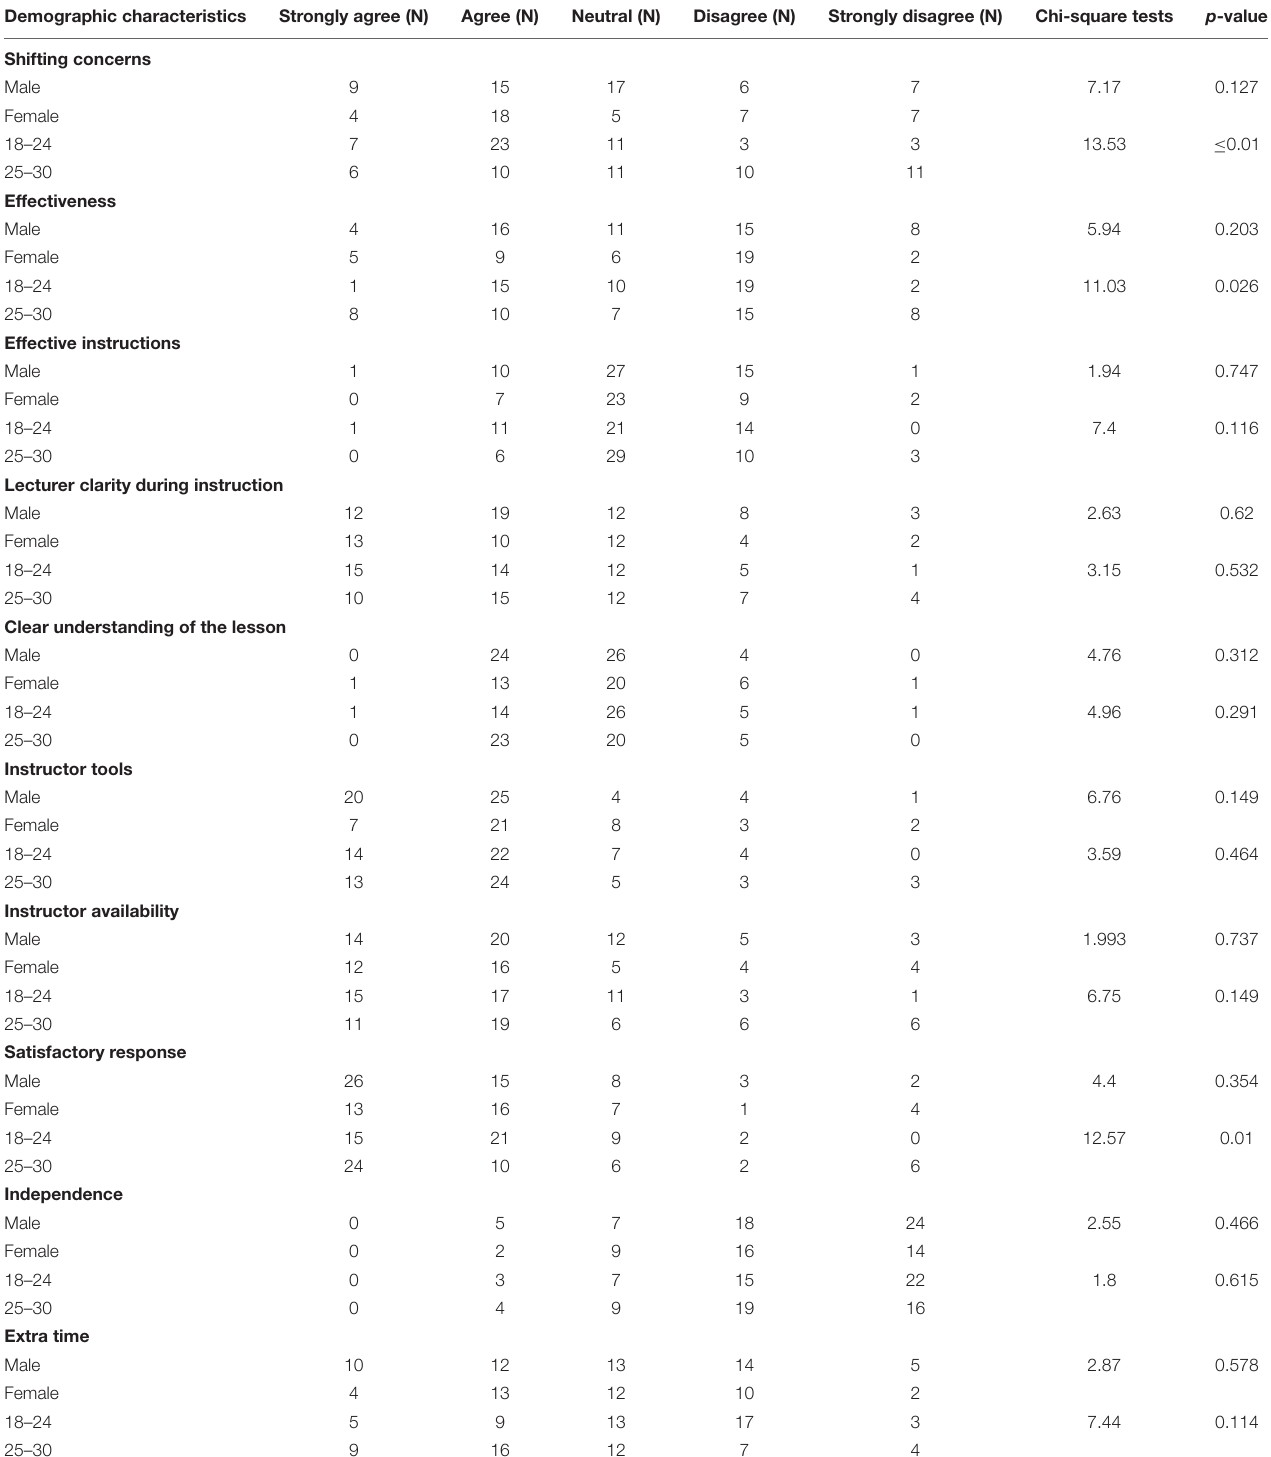
TABLE 5 | Comparison of demographic characteristics and different parameters for face-to-face learning. Demographic characteristics Strongly agree (N) Agree (N) Neutral